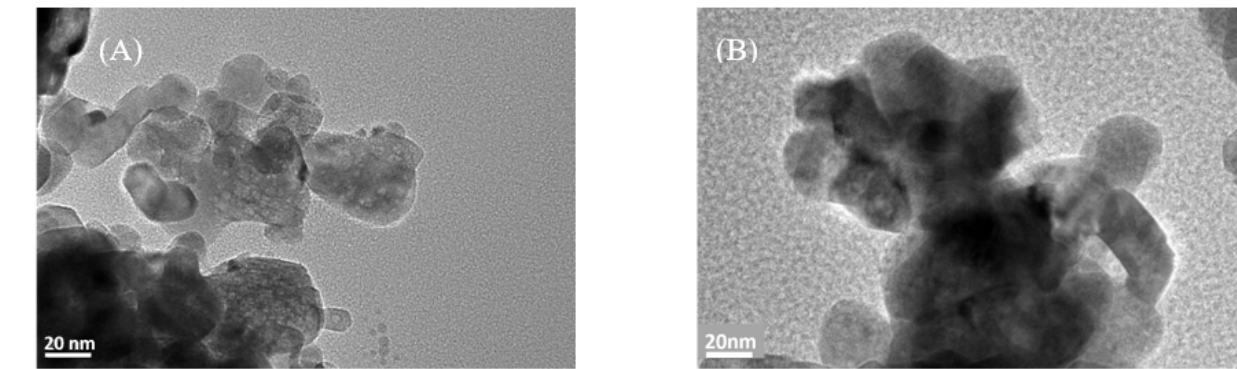
Figure 7. TEM micrograph images at magnification of 200,000× for ( A ) fresh and ( B ) spent 5Ni+4Gd/YZr catalysts.